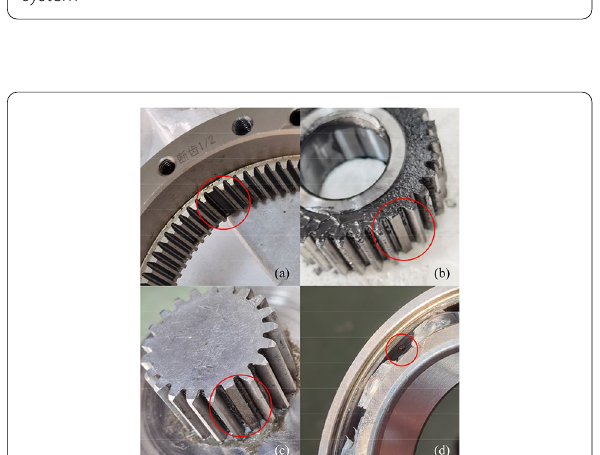
Figure 9 Defective component of the experimental planetary gearing system: a tooth fracture of the ring gear, b tooth fracture of the sun wheel, c tooth fracture of the planetary gear, and d outer race pitting of the rolling bearing